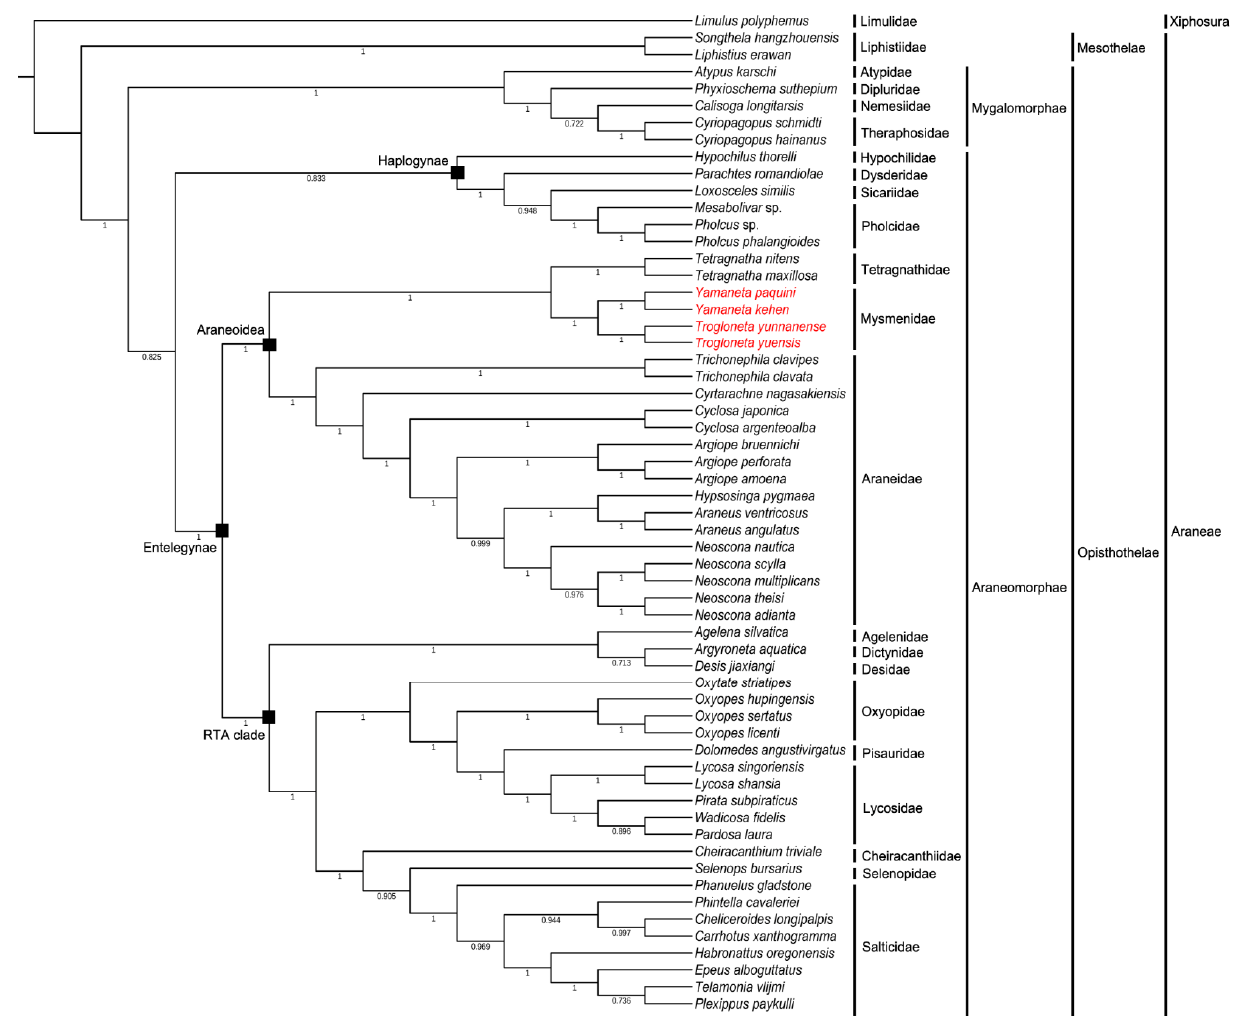
Figure 5. Phylogenetic tree from Araneae species based on nucleotide sequence of 13 PCGs and 2 rRNAs using Bayesian inference (BI). Limulus polyphemus was used as an outgroup. Numbers below the nodes refer to Bayesian posterior probabilities in percentages. The specimen used in our experiment are marked in red.